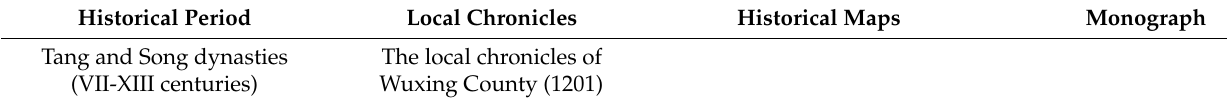
Table 1. Main historical sources analyzed for investigating the origin and the evolution of